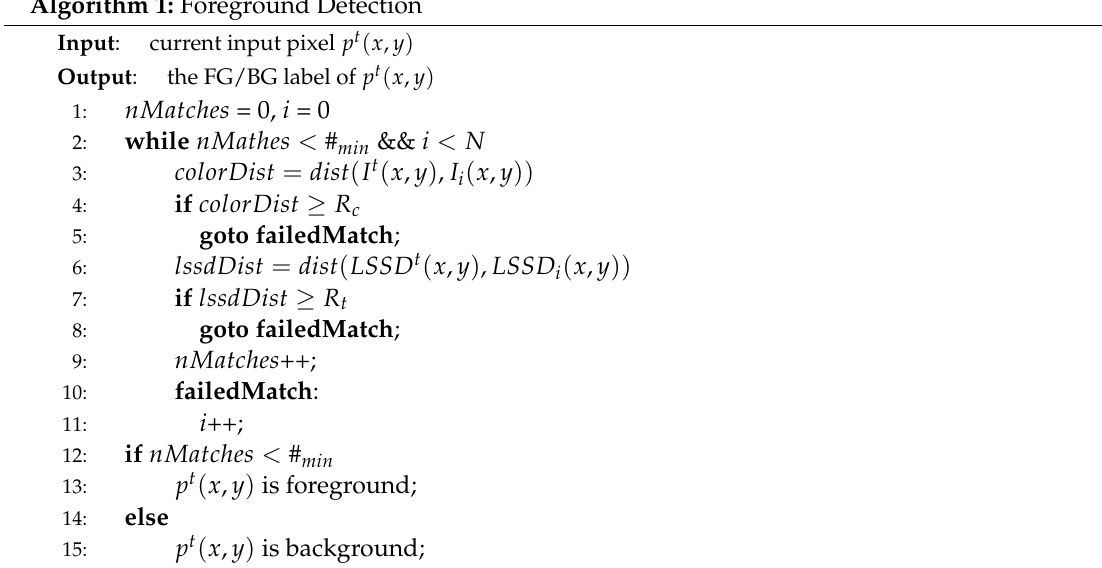
Algorithm 1: Foreground